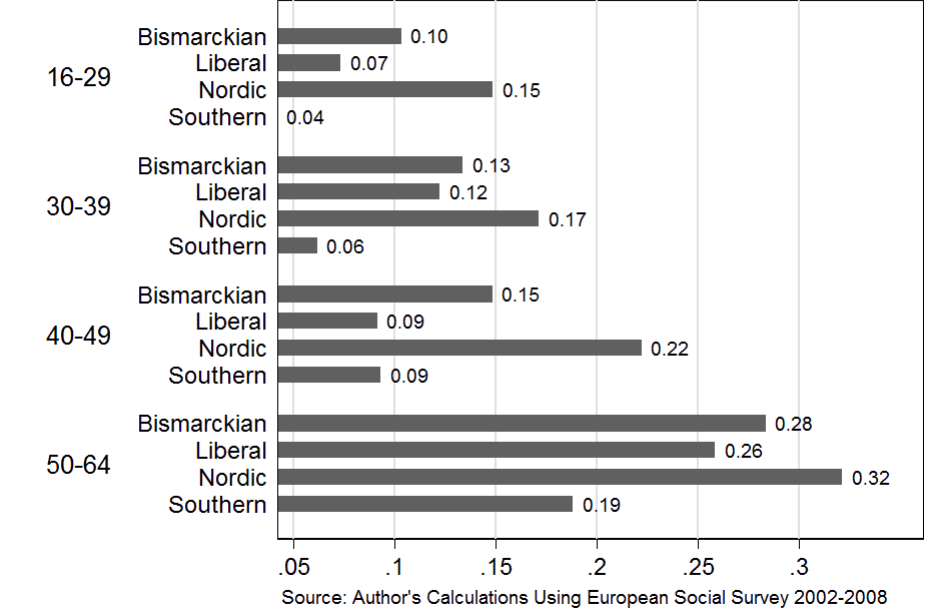
Figure 2: Proportion of Working Age Adults Reporting Disability by